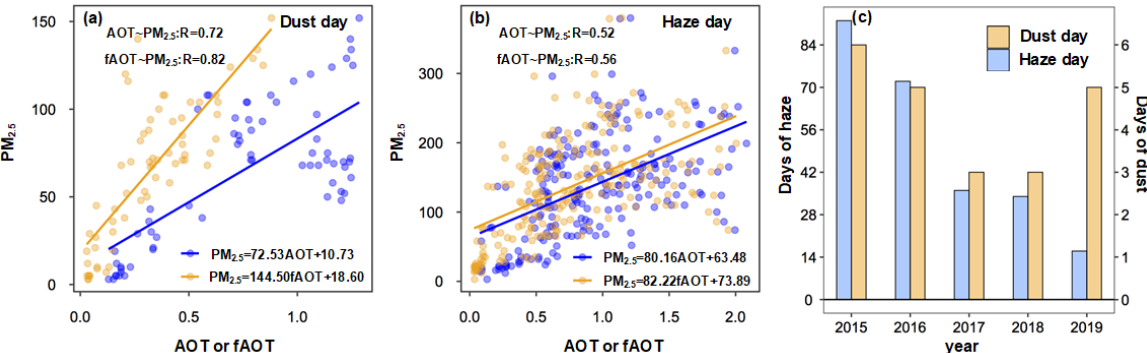
Figure 11. ( a ) Linear correlation between AERONET AOT (blue) and fAOT (orange) and PM 2.5 on dust days during 2015–2019; ( b ) linear correlation between AERONET AOT (blue) and fAOT (orange) and PM 2.5 on haze days during 2015–2019; ( c ) the number of haze and dust days occurring every year during 2015–2019.